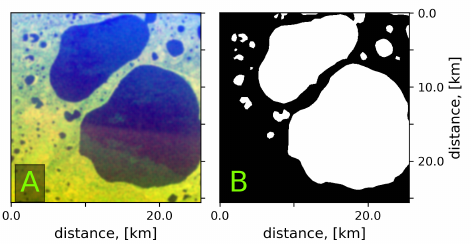
Figure 3. A pseudo-RGB Sentinel-1 image (R: HV-polarization; G: HH-polarization; B: incidence angle) taken over the Yamal Peninsula on 12 August 2015 at 12:40:52, containing tundra lakes with different shapes and sizes ( A ), and a binary image with manually extracted tundra lakes ( B ), where the white color corresponds to the tundra lake